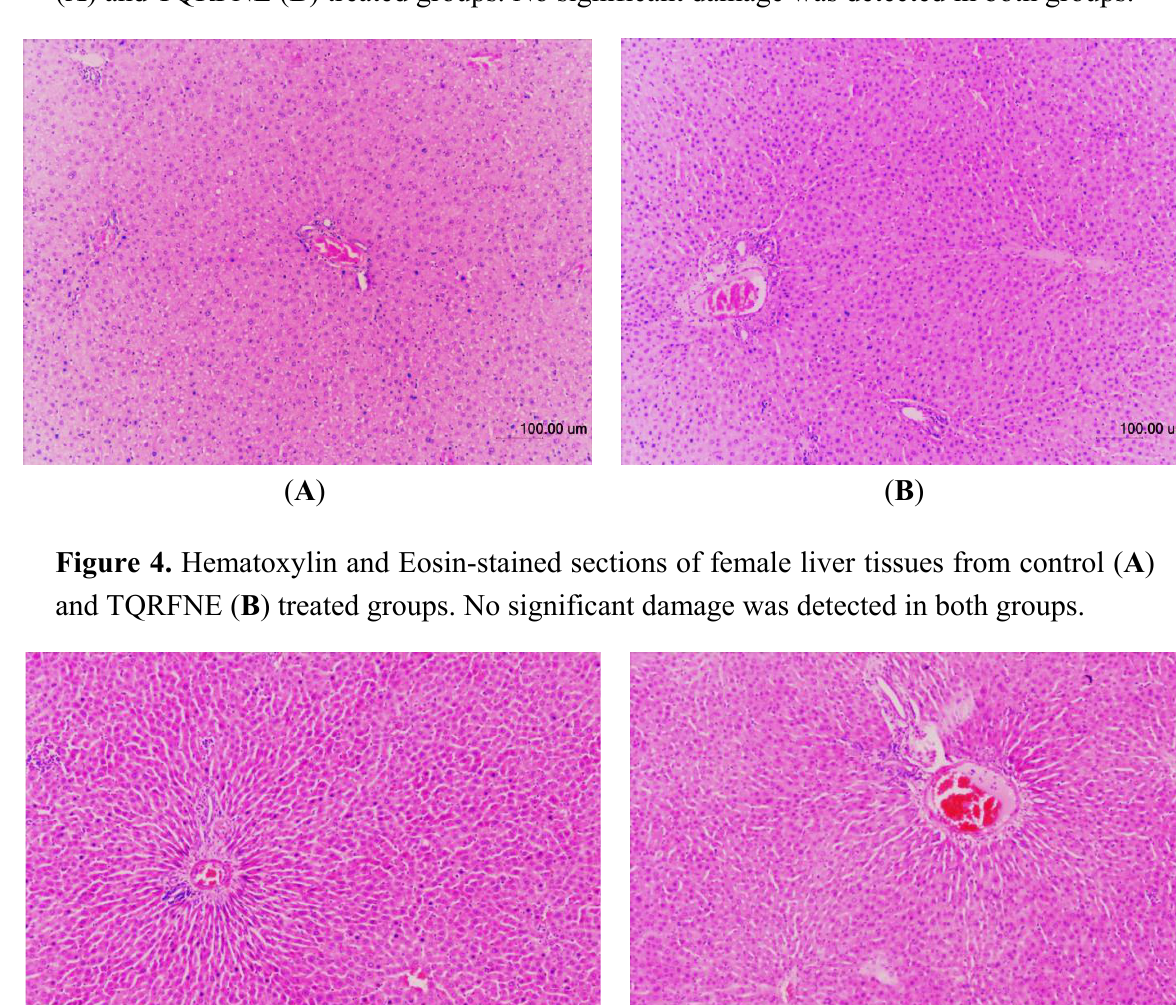
Figure 3. Hematoxylin and Eosin-stained sections of male liver tissues from control ( A ) and TQRFNE ( B ) treated groups. No significant damage was detected in both groups.